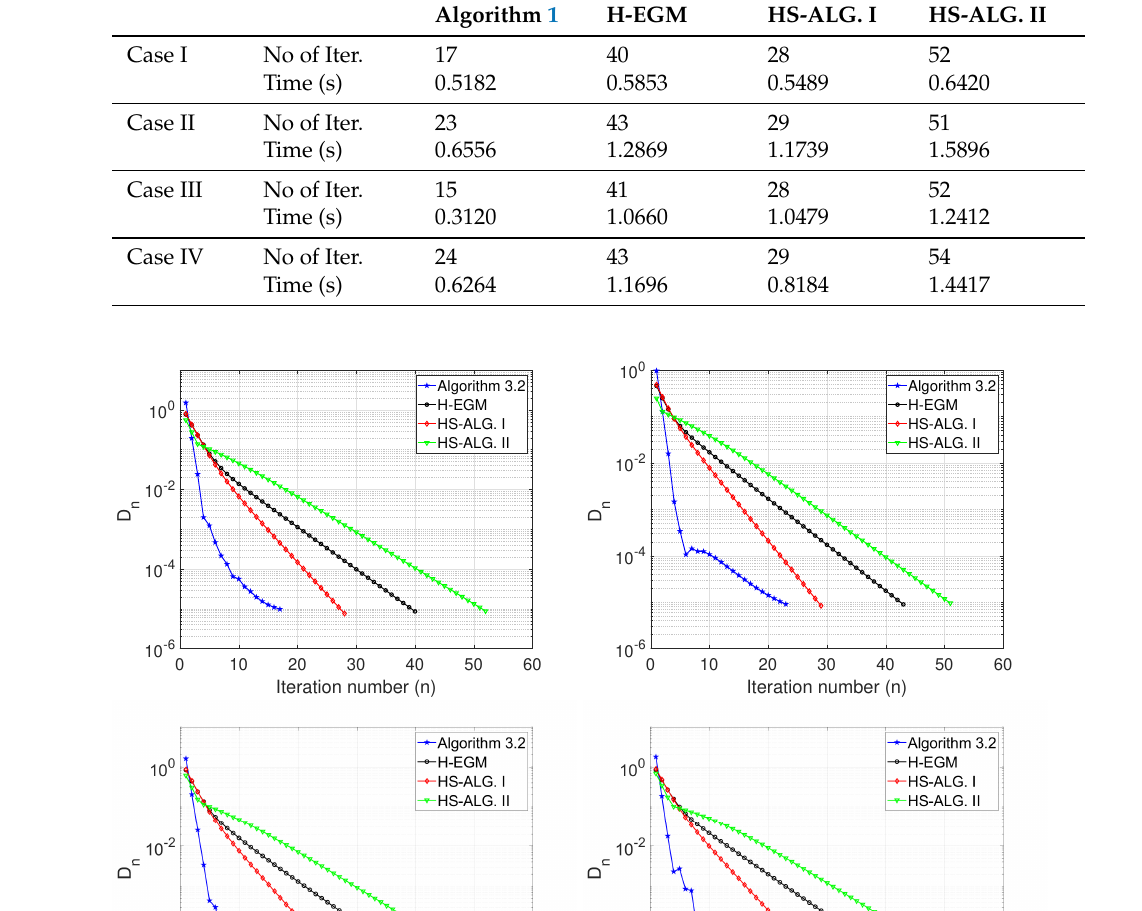
Table 2. Computational result for Example 2.